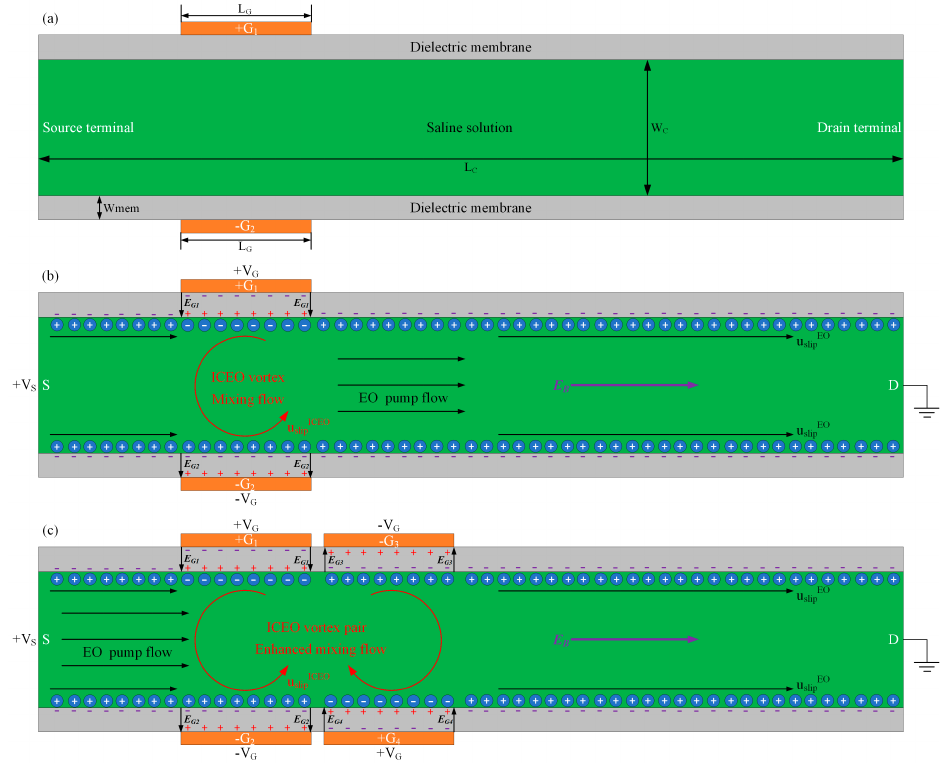
Figure 1. 2D schematic diagrams of the microfluidic device for bipolar DC field-effect electroosmosis control. ( a ) Geometric configuration of a bipolar DC flow field-effect-transistor (DC